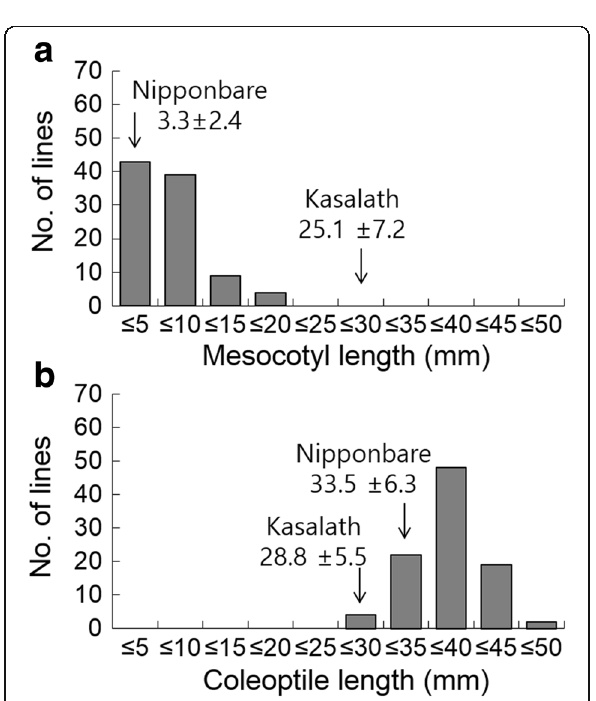
Fig. 3 Frequency distribution of the mesocotyl length ( a ) and coleoptile length ( b ) in 98 backcross inbred lines (BILs) derived from Nipponbare/Kasalath at 5 cm soil depth; Arrowheads indicate mean values for Nipponbare and Kasalath. 12 seeds of 98 BILs, Nipponbare and Kasalath were sown at 5 cm soil depth and incubated at alternate temperatures of 30 °C and 26 °C (14 h/10 h). At 14 days after sowing, length were